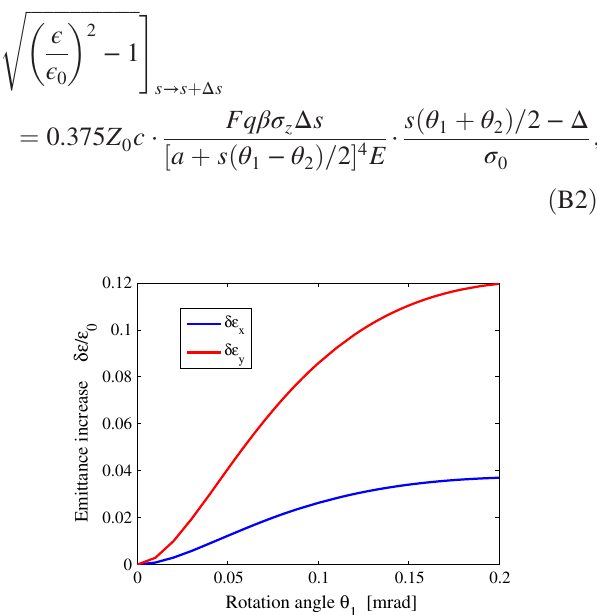
ffiffiffiffiffiffiffiffiffiffiffiffiffiffiffiffiffiffiffiffiffi (cid:3) ϵ